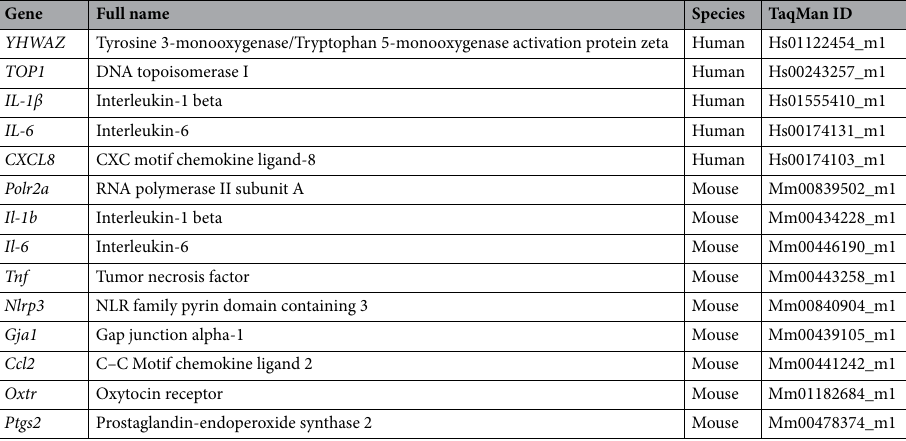
Table 2. TaqMan gene expression assay